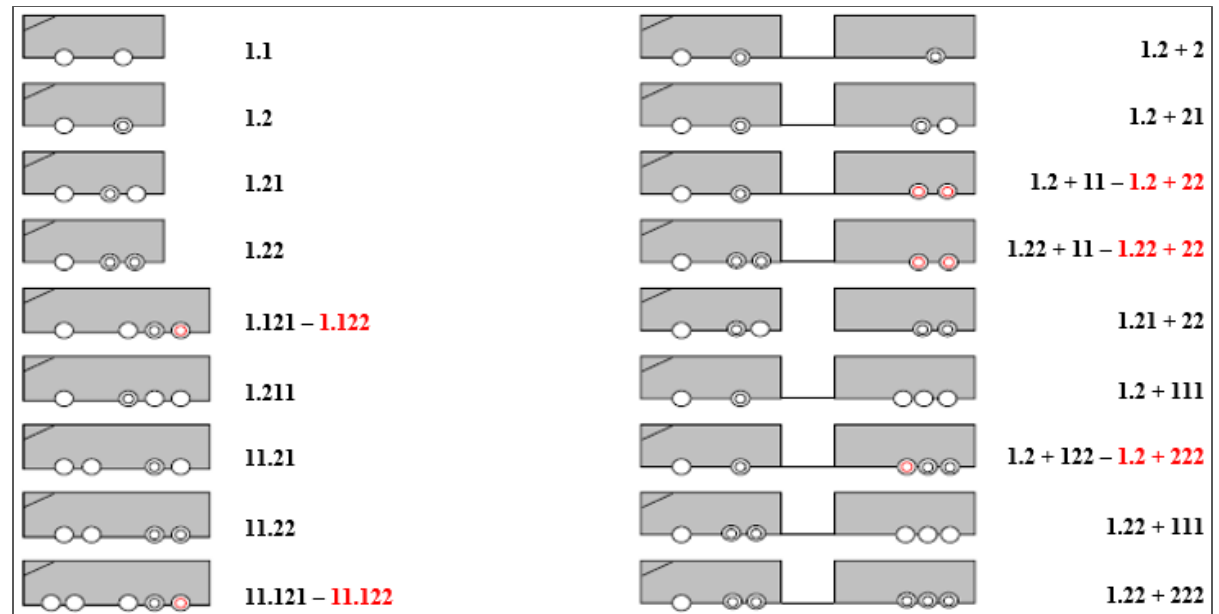
Figure 6. Axle types used in heavy vehicles.